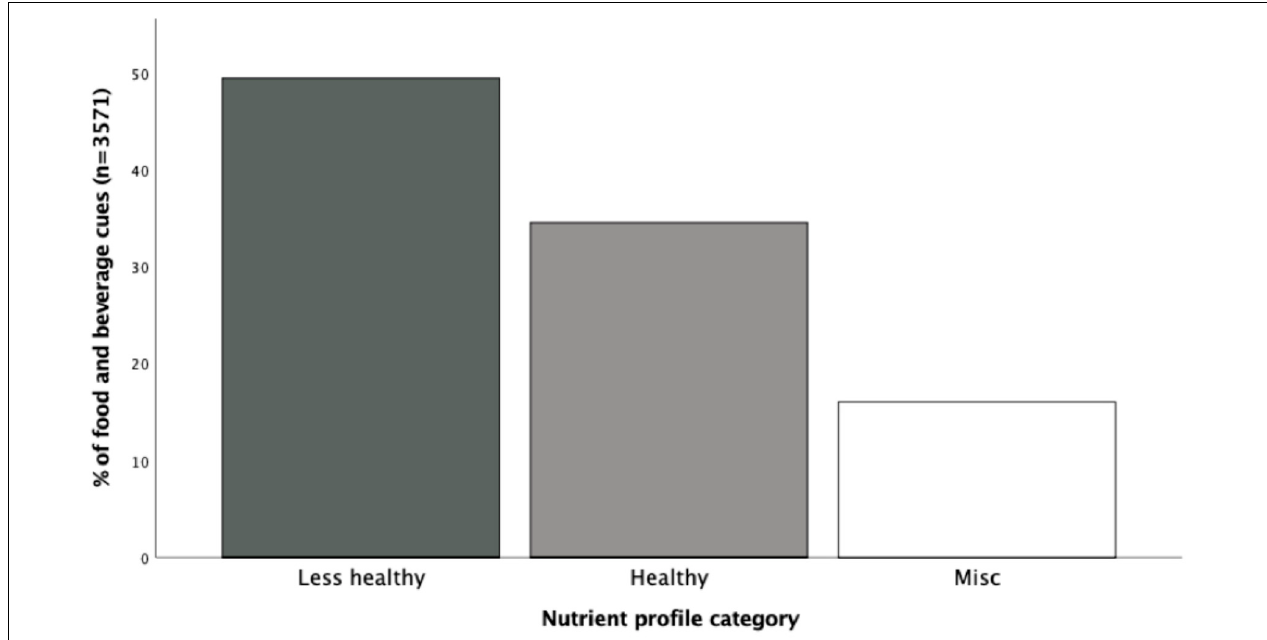
FIGURE 1 | The percentage of food and beverage cues categorized by nutrient profile according to the UK Nutrient Profiling Model.